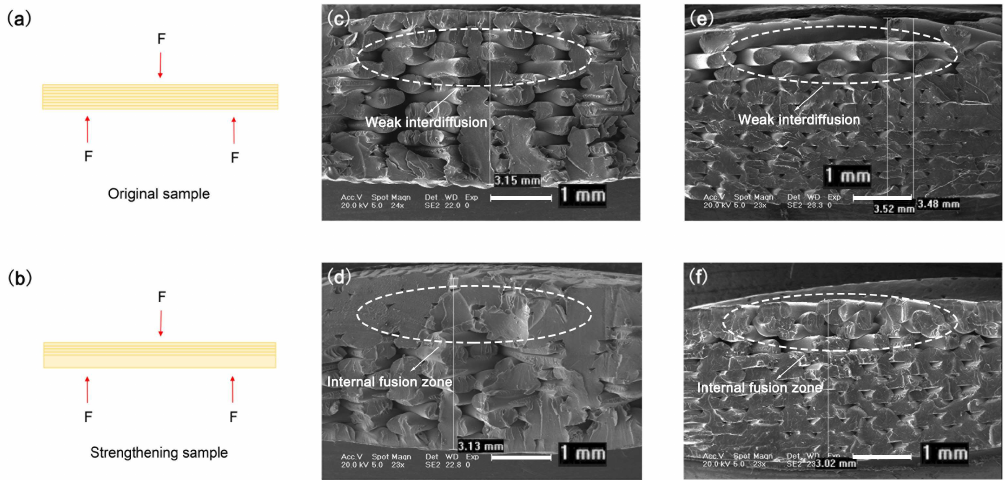
Figure 5. Schematic illustration showing: bending load of original samples ( a ); and ultrasonic-strengthened samples ( b ). SEM images of fractured surfaces of bending samples: original ABS samples ( c ); ultrasonic-strengthened ABS samples ( d ); original PLA samples ( e ); and ultrasonic-strengthened PLA samples ( f ).